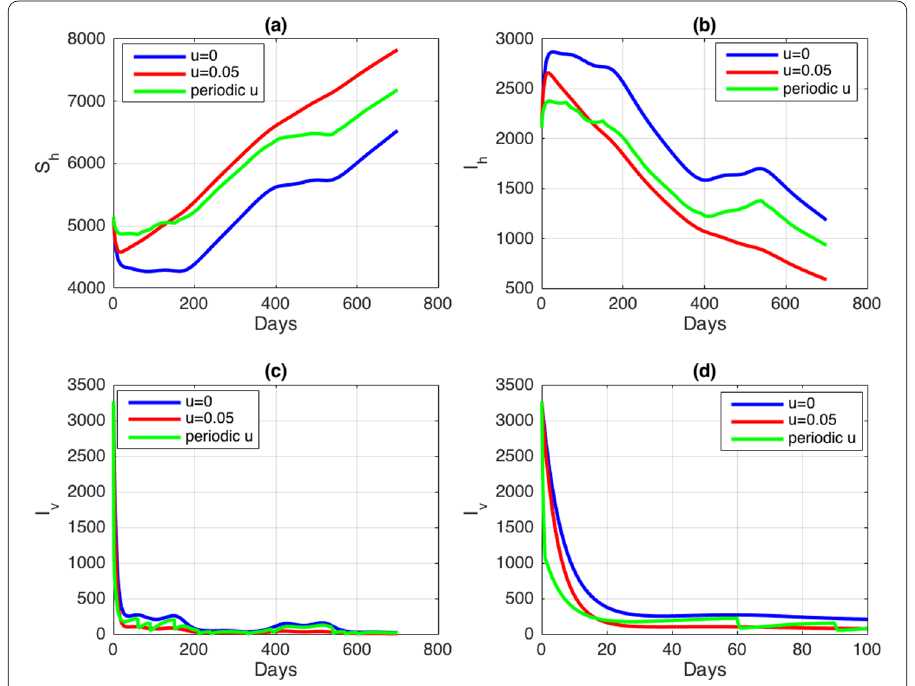
Figure 4 Autonomous simulations of the effects of changes in parameter u . The blue curve represents no fumigation, the red curve represents fumigation with constant u = 0.05, and the green curve represents two seasons of impulse fumigation